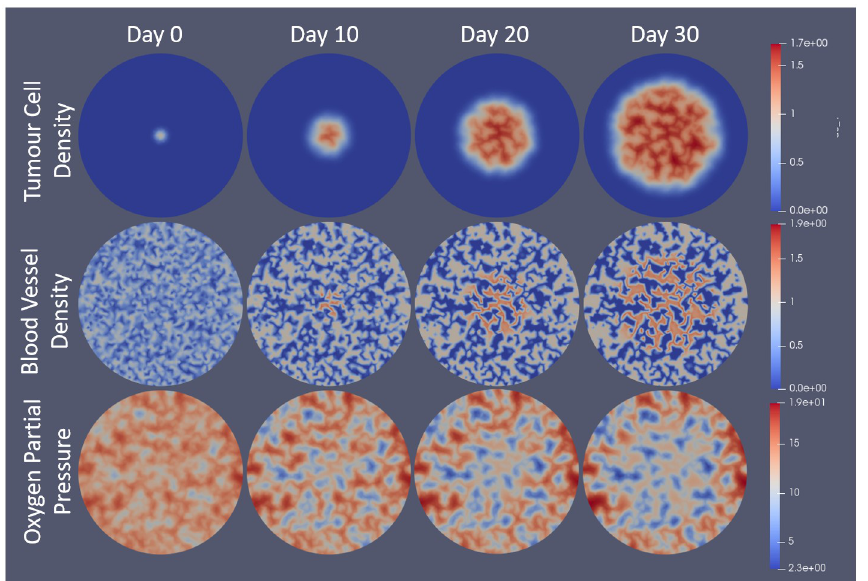
Fig 3. Visualization of model results for tumour cell density, blood vessel density, and oxygen partial pressure over a 30 day span with no treatment. Model is solved using the FEniCS Project Finite Element Solver [55, 56] and is visualized in Paraview [57]. Tumour cells begin as a normalized Gaussian distribution with a standard deviation of approximately 0.63mm. Vessels start randomly distributed between 0 and 1 over the domain. Oxygen is solved in quasi-steady state with respect to the time step length. Day 0 corresponds to the solution of the system after the first time step. Notice that vessels grow toward islands or tubes of density 0 and 1 in the absence of tumour cells, but will become overvascularized ( m > 1) in the presence of tumour cells. Also notice that the oxygen concentration decreases in tumour area due to the overvascularization. Scales on the right correspond to the nondimensional